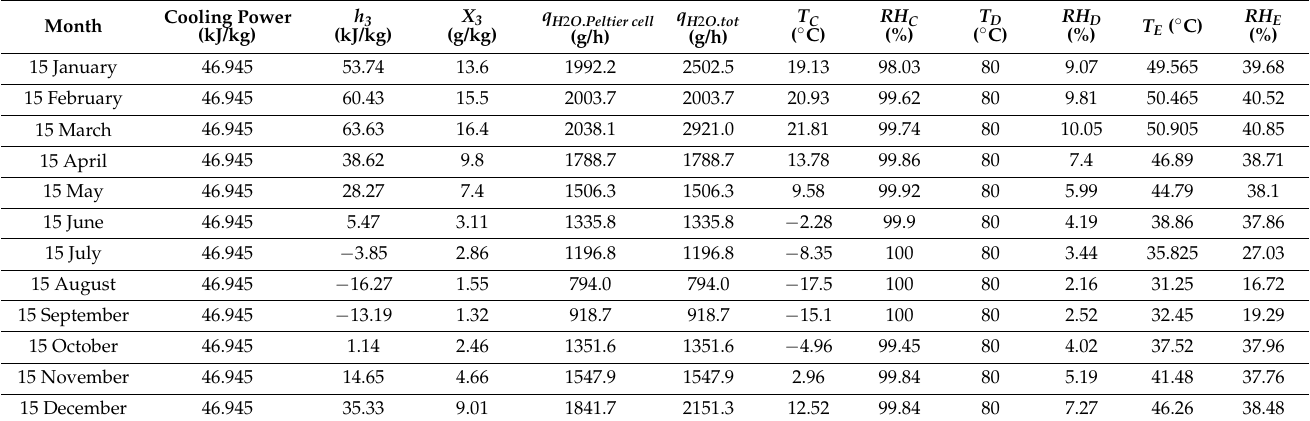
Table 8. Calculation of condensed water using 7 Peltier